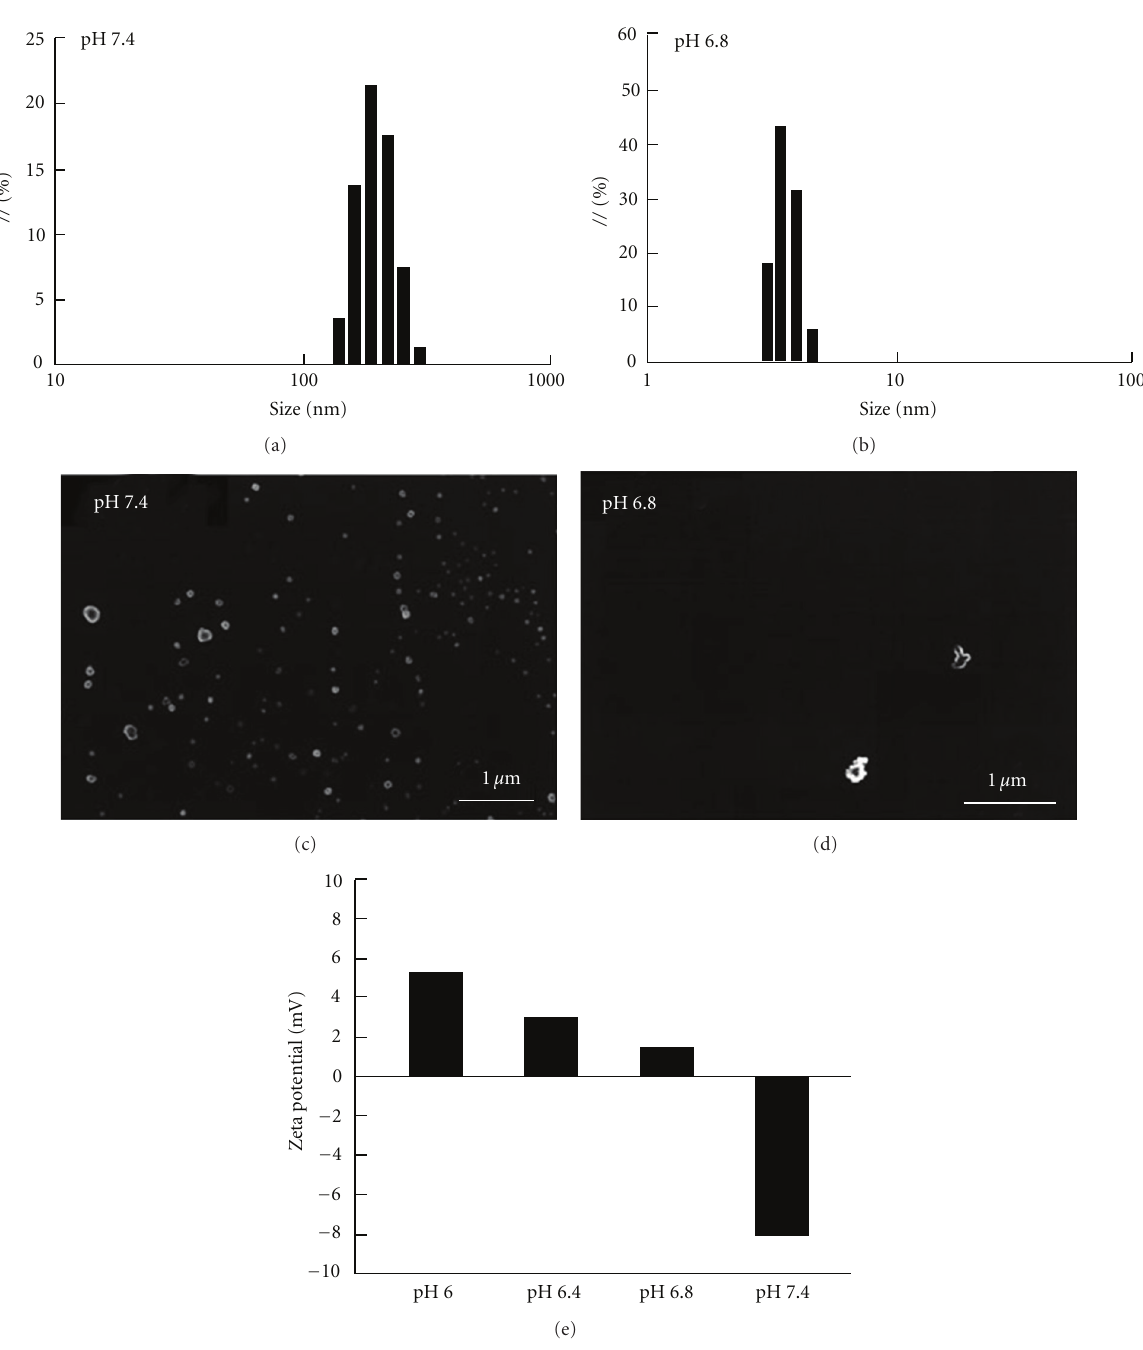
Figure 8: Characteristics of the polymeric carrier-PSs conjugate. Particle-size distribution of polymeric PSs (0.1mgmL − 1 ) at (a) pH 7.4 (PBS 150mm) and (b) pH 6.8 (PBS 150 mm) by Zetasizer. Field-emission scanning electron microscopic (FE/SEM) images of polymeric PSs